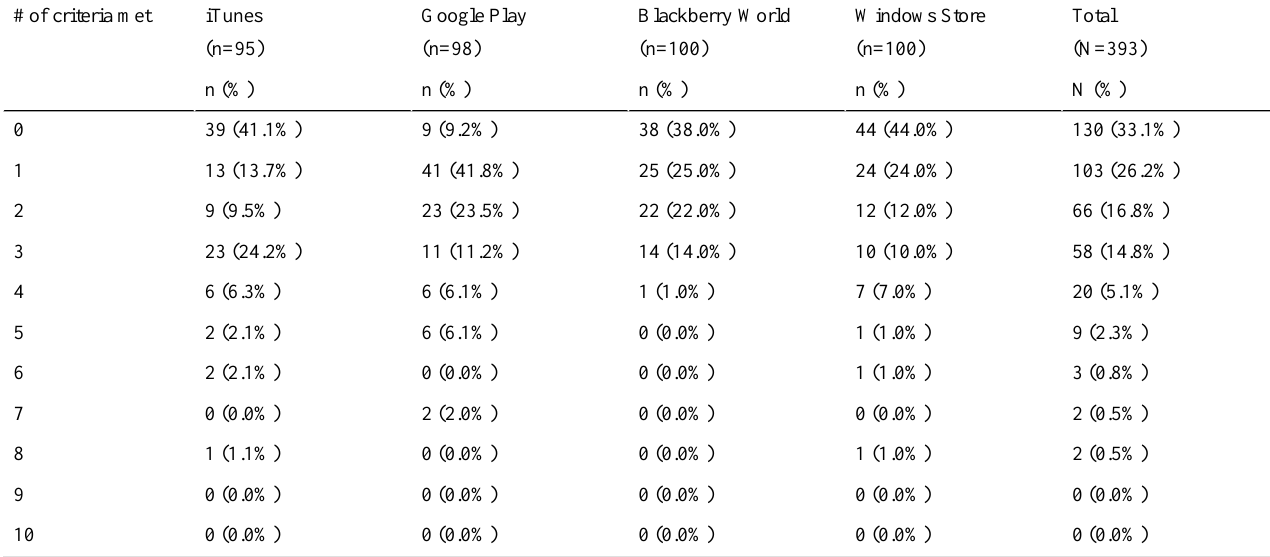
Table 2. Comprehensiveness of apps for assessment